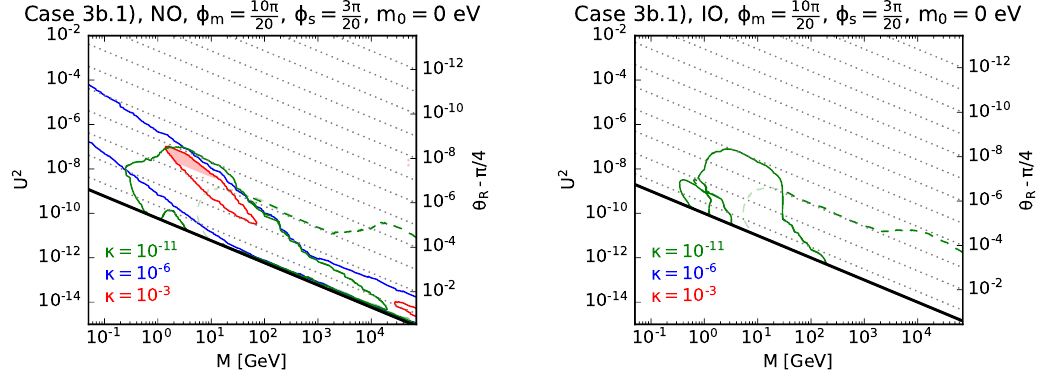
Figure 25 . Case 3 b.1) Range of total mixing angle U 2 consistent with leptogenesis for the Majorana mass M varying between 50 MeV and 70 TeV. The splitting κ is chosen among the three values κ ∈ { 10 − 3 , 10 − 6 , 10 − 11 } . However, we note that for κ = 10 − 3 and κ = 10 − 6 the observed amount of BAU can only be generated for light neutrino masses with strong NO (left plot) and not for light neutrino masses with strong IO (right plot). The angle θ can be read off. The values of R and φ = 3 π corresponding to m even and s odd. The contours φ m and φ s are fixed to φ m = 10 π s 20 20 corresponding to positive (negative) values of the BAU are shown in continuous (dashed) lines. Note that these refer to vanishing initial conditions except for the lines shown in fainter colours. The red shaded area shows the region in which a condition like the one in eq. (3.69) is not fulfilled. The black lines indicate the seesaw